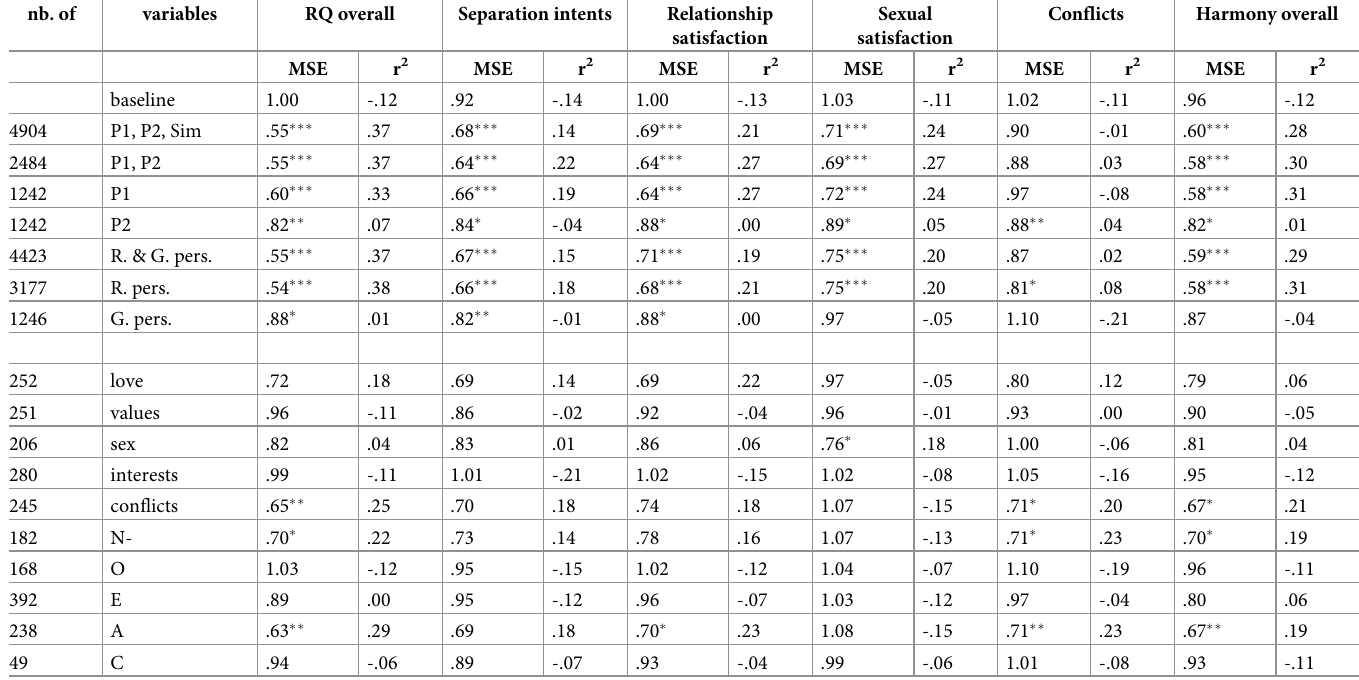
Table 4. 10 � 10-fold CV performance of the elastic net models based on different variable sets (n = 192). nb.